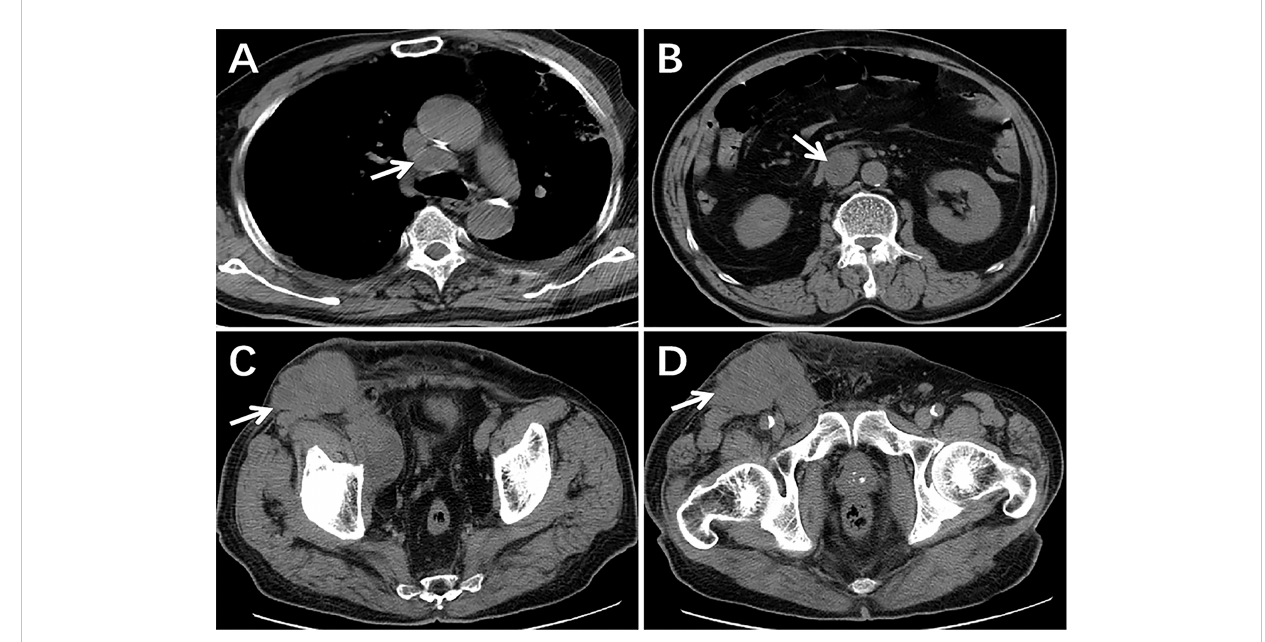
FIGURE 4 The CT scans following two cycles of treatment. There were still lesions in the mediastinum, retroperitoneum, pelvic, and inguinal regions and the size and quantity of lymph nodes had not decreased signi fi cantly from pre-treatment imaging (arrows) (A – D)